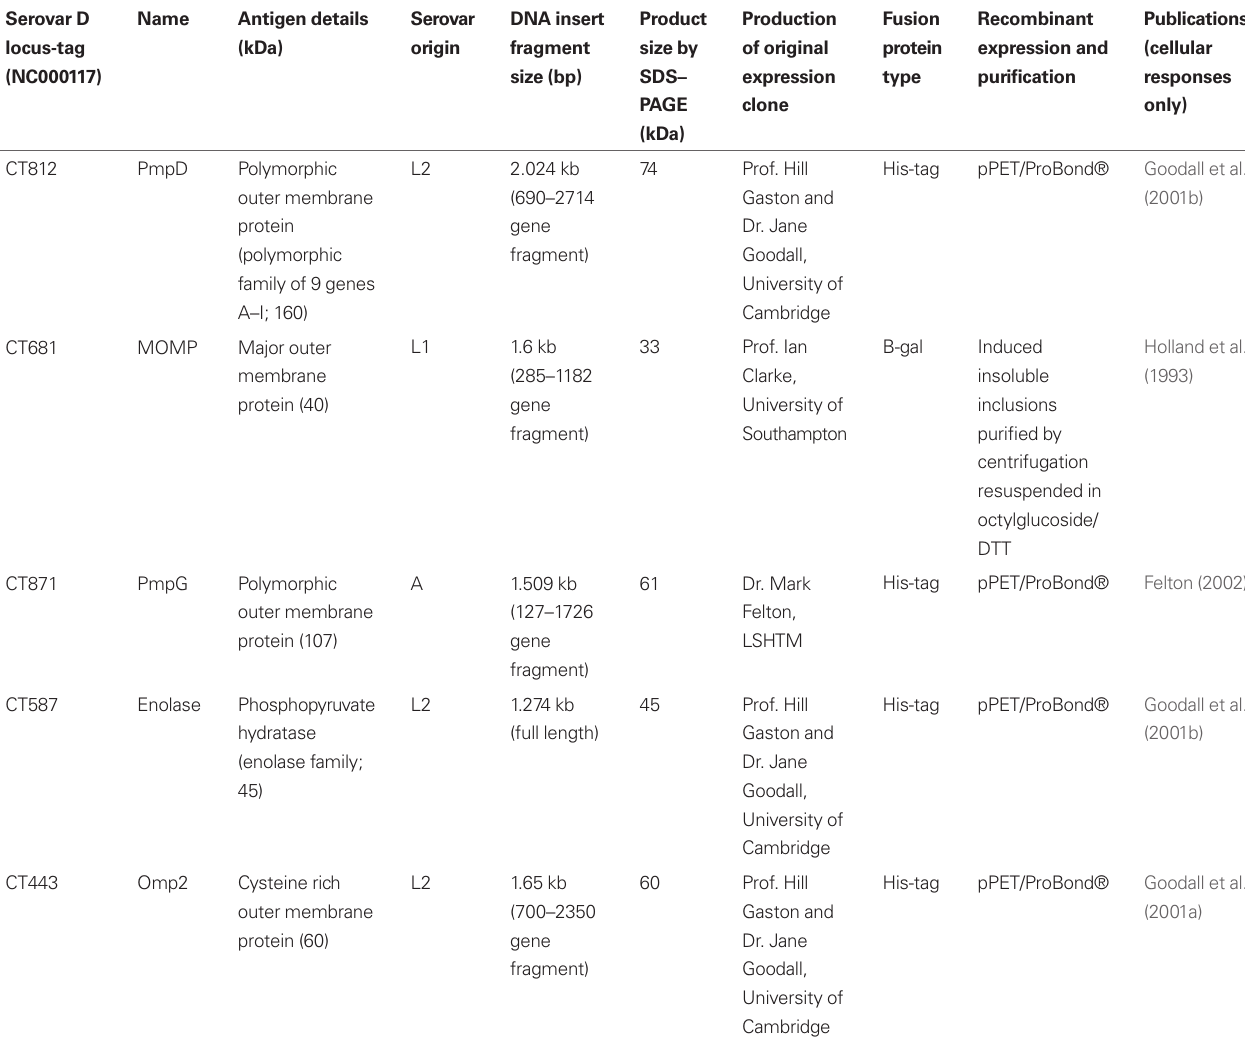
Table 2 | Summary of recombinant antigens used. Serovar d locus-tag